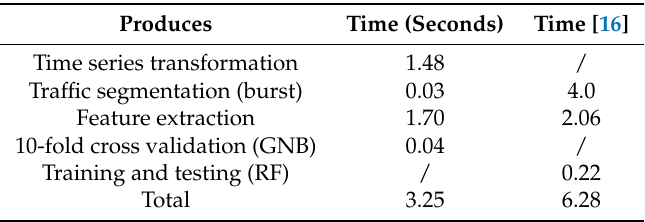
Table 4. Computational